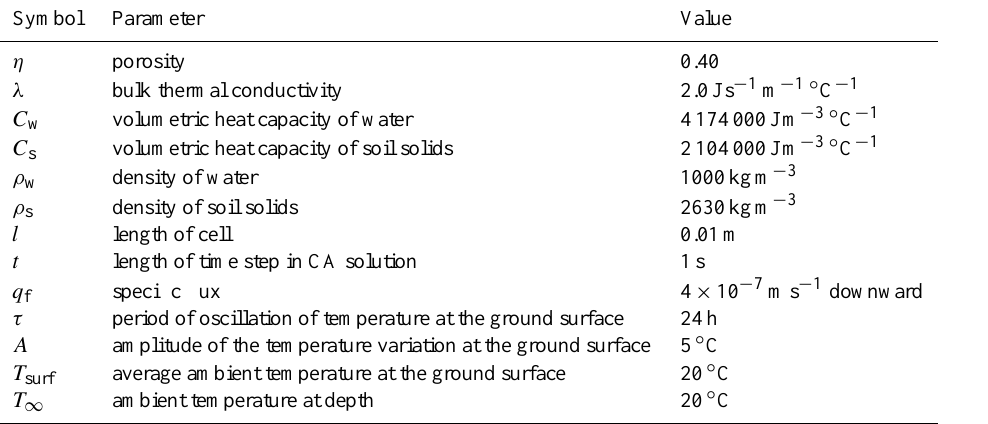
Table 2. Simulation parameters for predicting the subsurface temperature profile in a semi-infinite porous medium in response to a sinusoidal surface temperature. The analytical solution to this one-dimensional heat convection and conduction problem in response to a time varying Dirichlet boundary is given by Eqs. (14)–(17) as per Stallman (1965).